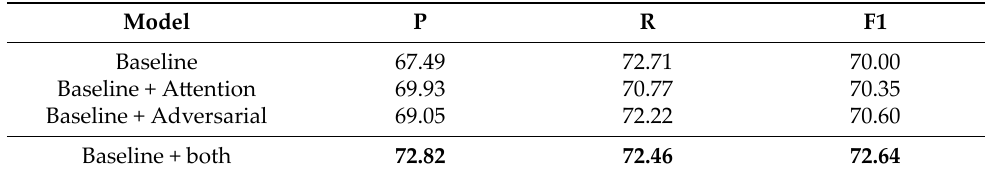
Table 5. Performances of the various component on Weibo NER